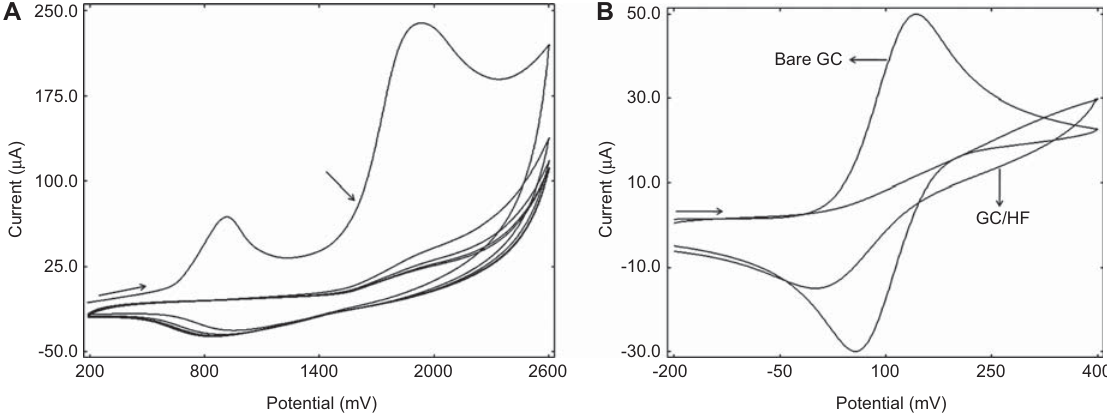
Figure 2 (A) Cyclic voltammogram of 1 m m HF in 0.1 m TBATFB, + 0.2 V and + 2.6 V potential range using 100 mV s -1 with fi ve cycles; (B) surface characterization with ferrocene.